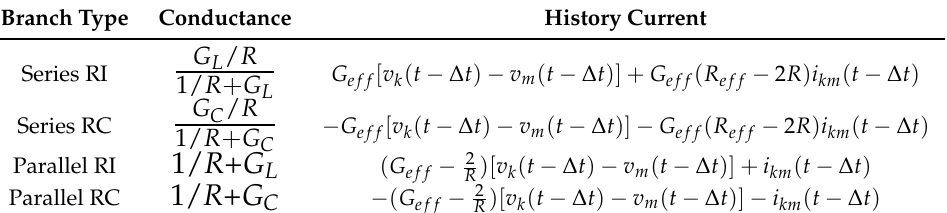
Table 2. Norton equivalents of RI/RC branches.